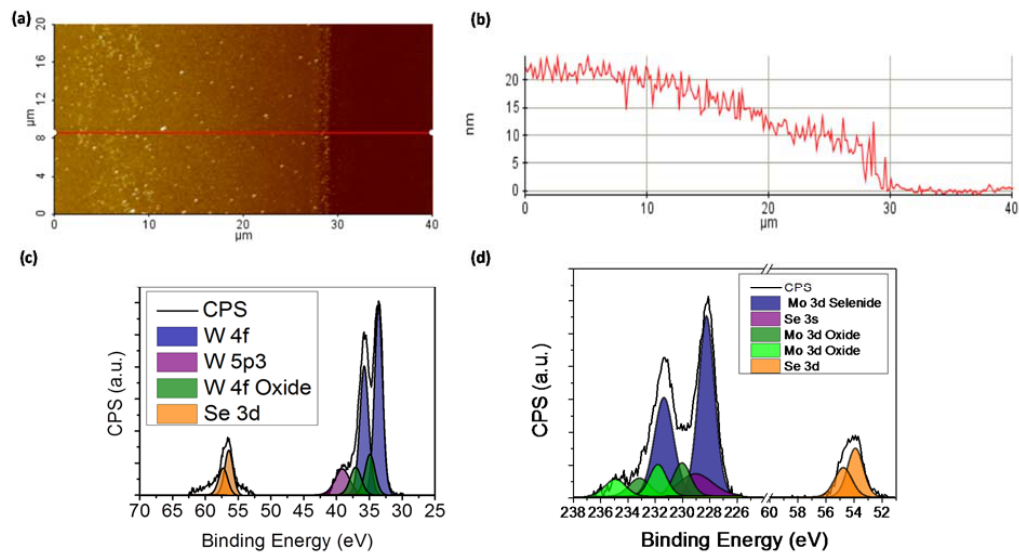
Figure 2. Characterization of TMD films. ( a ) AFM image of MoSe 2 . The area between 30 and 40 µm represents the bare SiO 2 substrate. ( b ) Surface profile of MoSe 2 according to the red line presented in panel (a). ( c , d ) XPS data and spectral fitting of WSe 2 and MoSe 2 , respectively.